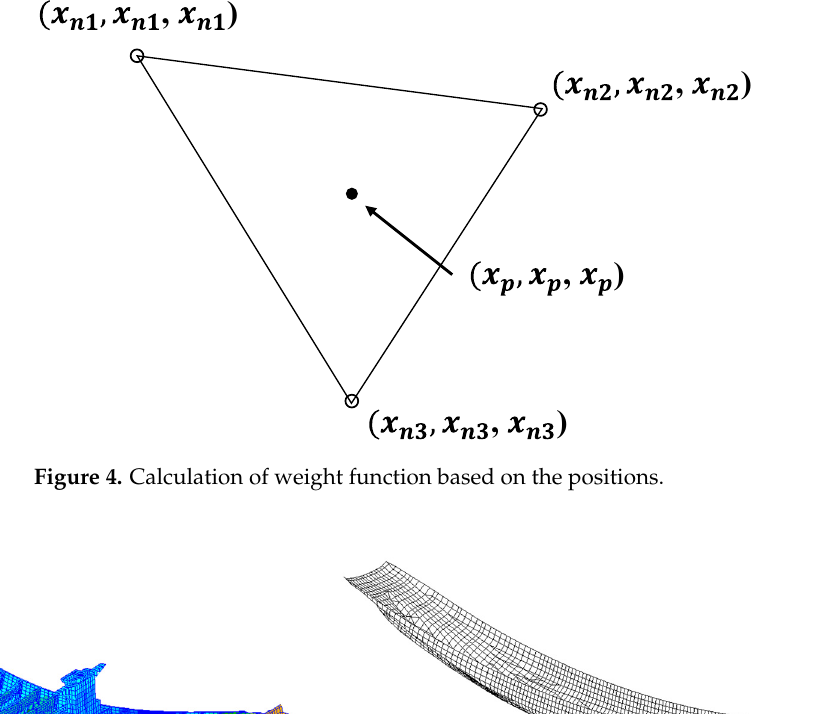
Here, j A is the eigenvector and , , a b c are weight functions. Figures 4 and 5 show how to linearly interpolate the eigenvectors and the correlation of each coordinate value.